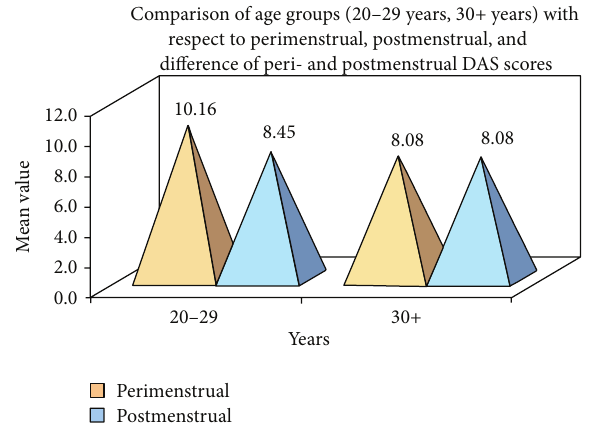
Figure 1: Comparison of age groups (20–29 years, 30+ years) with respect to perimenstrual, postmenstrual, and difference of peri- and postmenstrual DAS